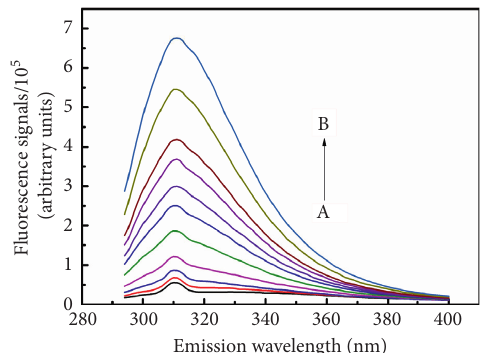
Figure 4: Fluorescence emission of black tea solution (tea � 0.2 mg/mL) with an increase in catechin concentration. Catechin varied from 0 μ g/mL to 10 μ g/mL. A to B indicates increased concentrations of catechin. The fluorescence intensity of the mixed solution gradually increased with the increase of catechin